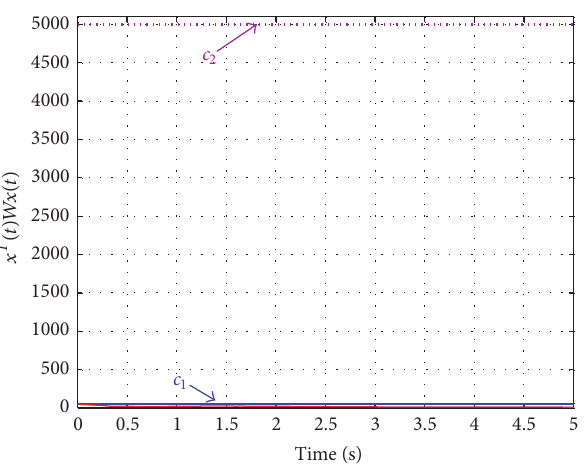
Figure 8: Time history of 𝑥 𝑇 (𝑡)𝑊𝑥(𝑡) .